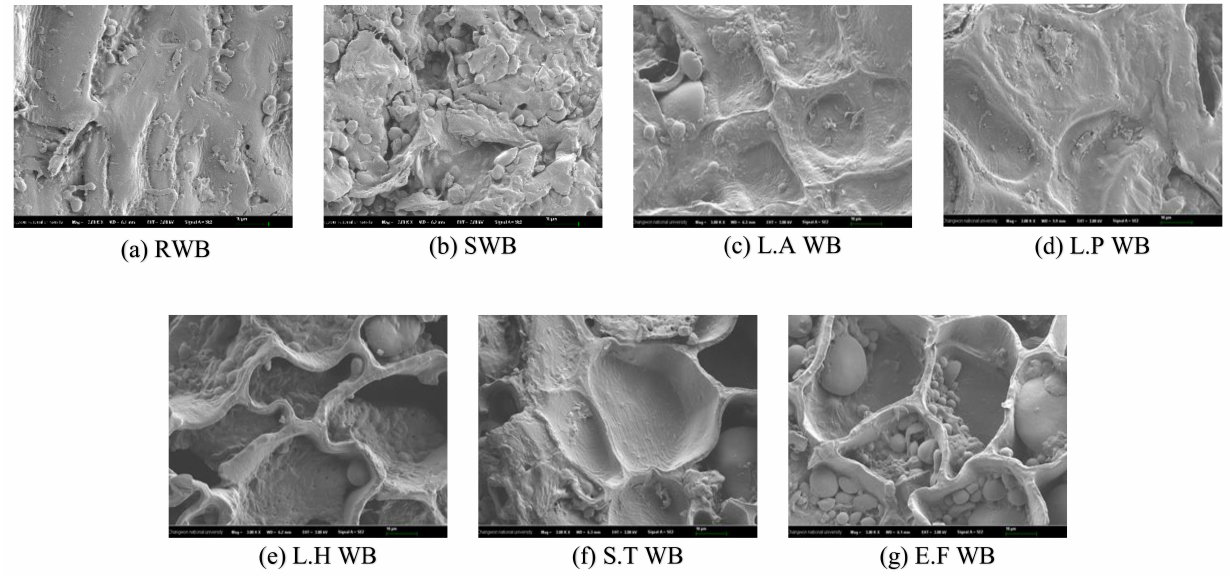
Figure 2. SEM images of raw and fermented wheat bran. RWB, raw wheat bran ( a ); SWB, sterilized wheat bran ( b ); L.A WB, wheat bran fermented with L. acidophilus ( c ); L.P WB, wheat bran fermented with L. plantarum ( d ); L.H WB, wheat bran fermented with L. helveticus ( e ); S.T WB, wheat bran fermented with S. thermophilus ( f ); E.F WB, wheat bran fermented with E. faecalis ( g ) (3000 ×